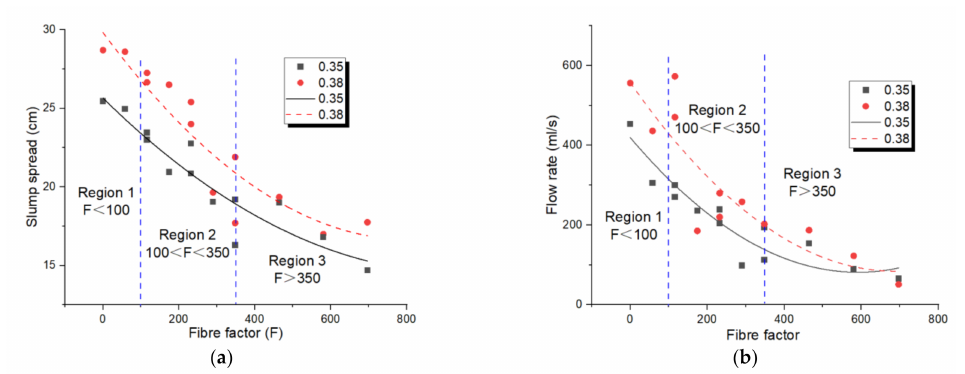
Figure 3. Relationships of ( a ) fibre factor–slump spread; ( b ) fibre factor–flow rate of PP fibre- reinforced